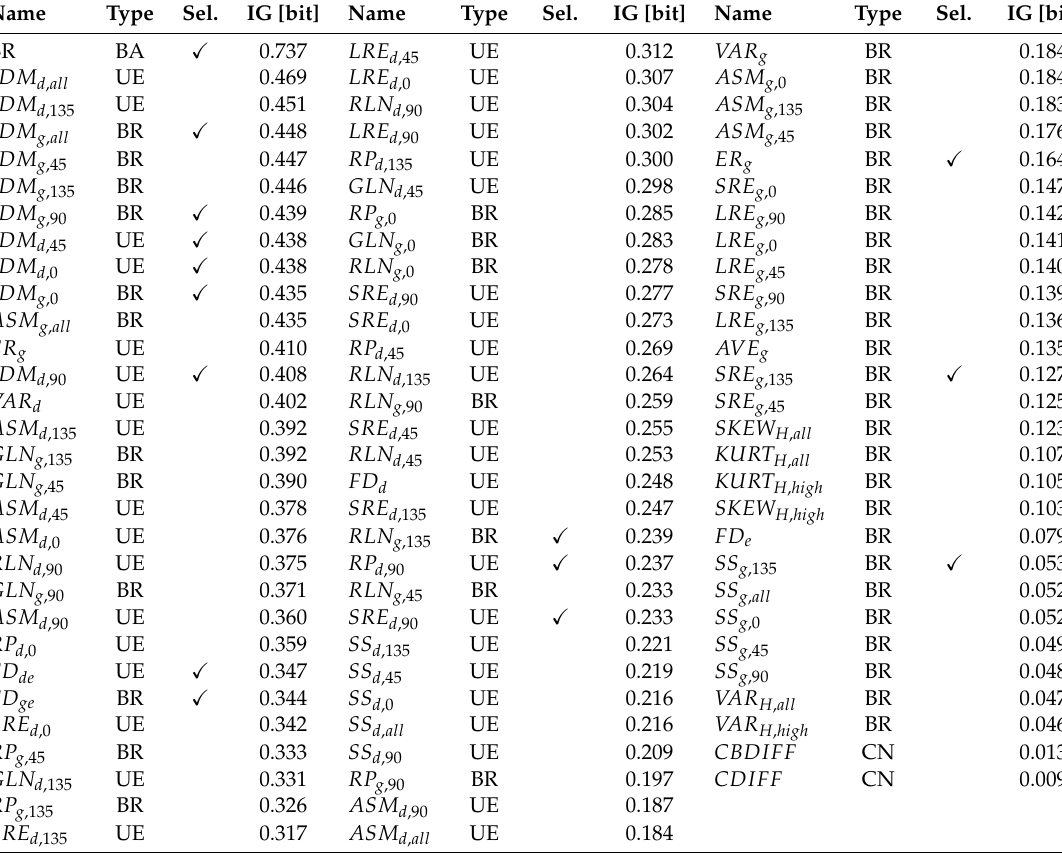
Table 7. List of the features for a Label (a check mark (cid:88) indicates that the feature was